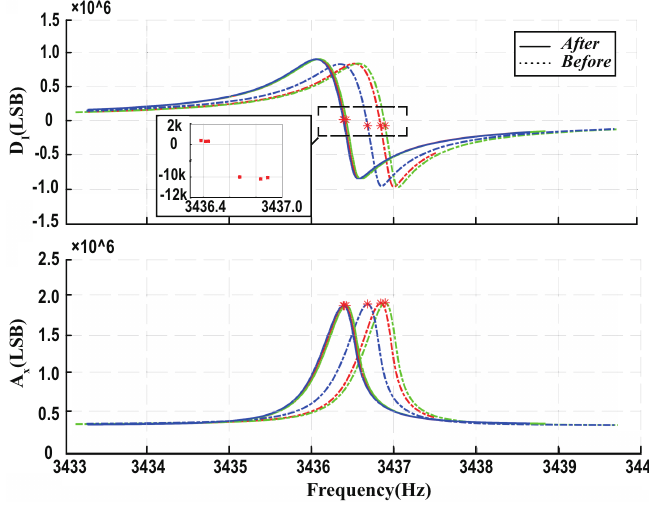
Figure 14. The results of the sweep frequency experiments before and after compensation.